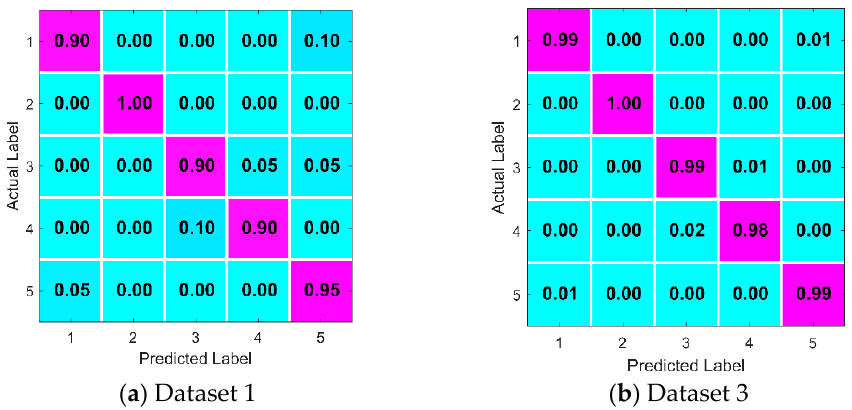
Figure 7. Confusion matrix under different data sets.